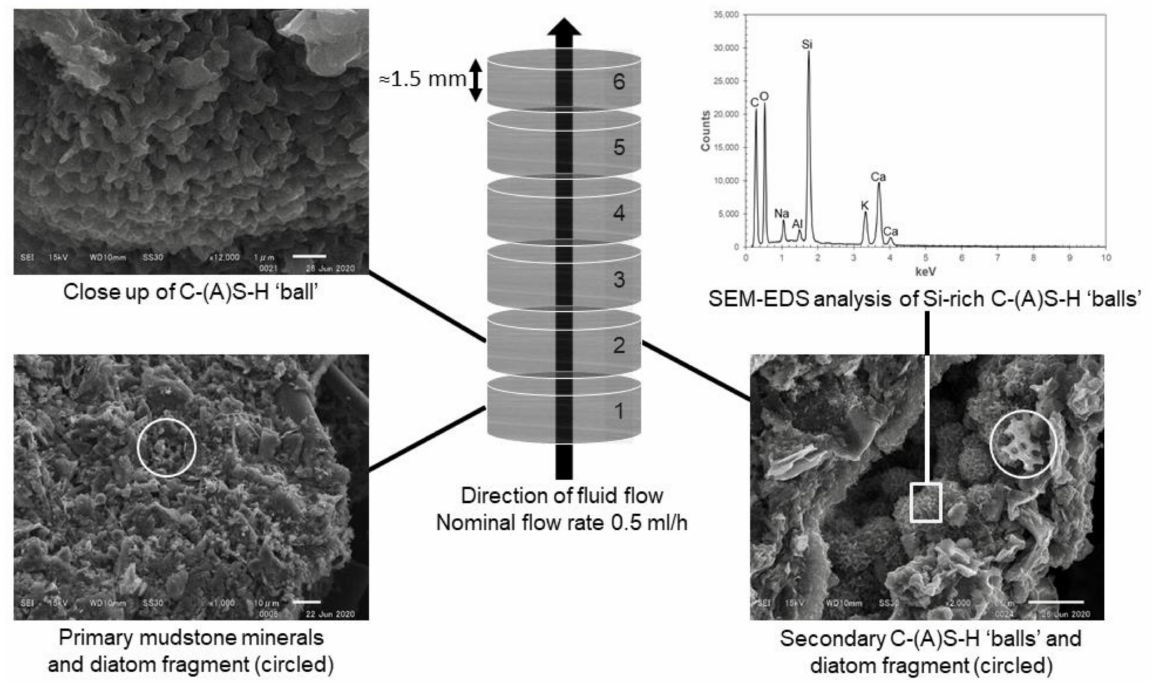
Figure 5. Summary of mineralogy, SFC experiment with the ‘young’ OPC leachate. Arrow indicates direction of flow; numerals refer to Section numbers. Each section was ~1.5 mm long. All SEM photos are secondary electron (SE) images. The white square in the SEM image from Section 2 indicates the area used for SEM-EDS analysis of C(A)-S-H phases.